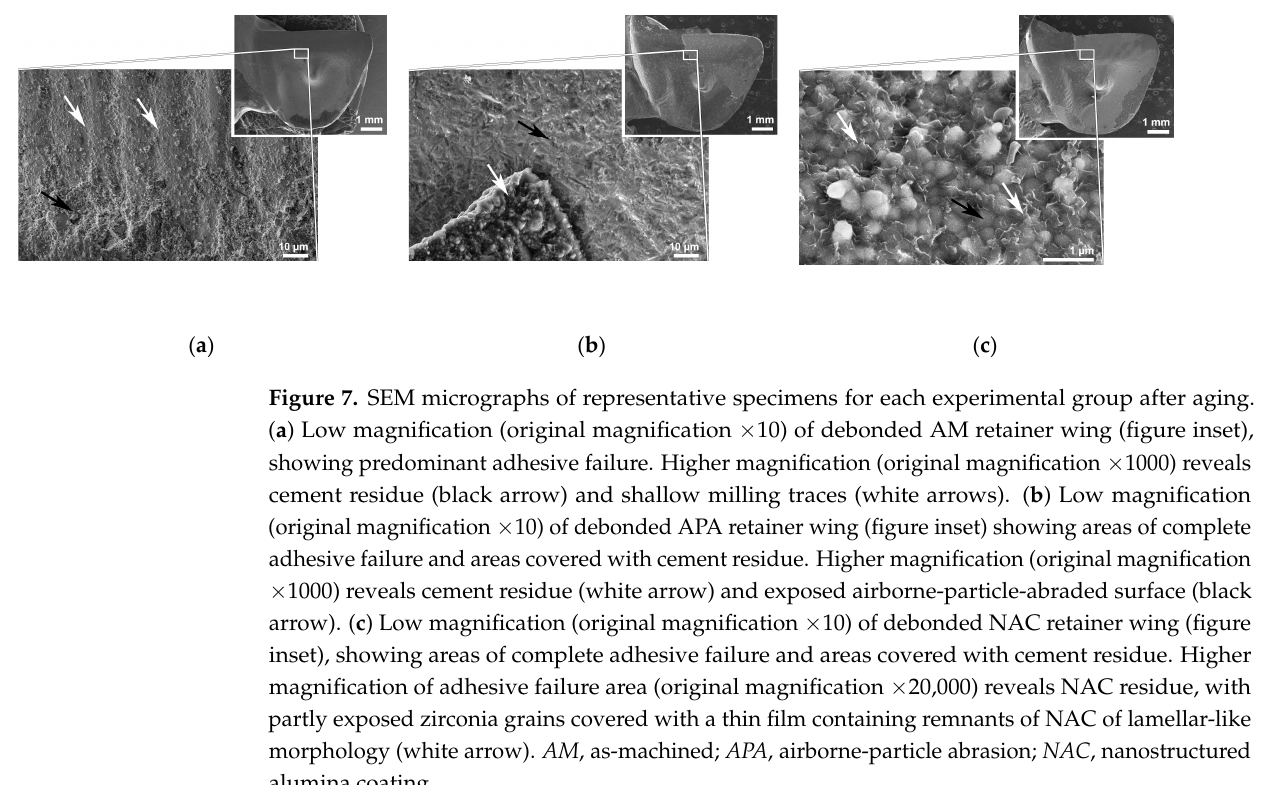
Figure 6. Mean percentages of retainer wing and abutment tooth bonding area covered with ce- ment residue after quasi-static loading of aged groups. The same upper-case le tt ers on the right side of each bar denote no statistical di ff erences between the groups ( p < 0.05). AM , as-machined;